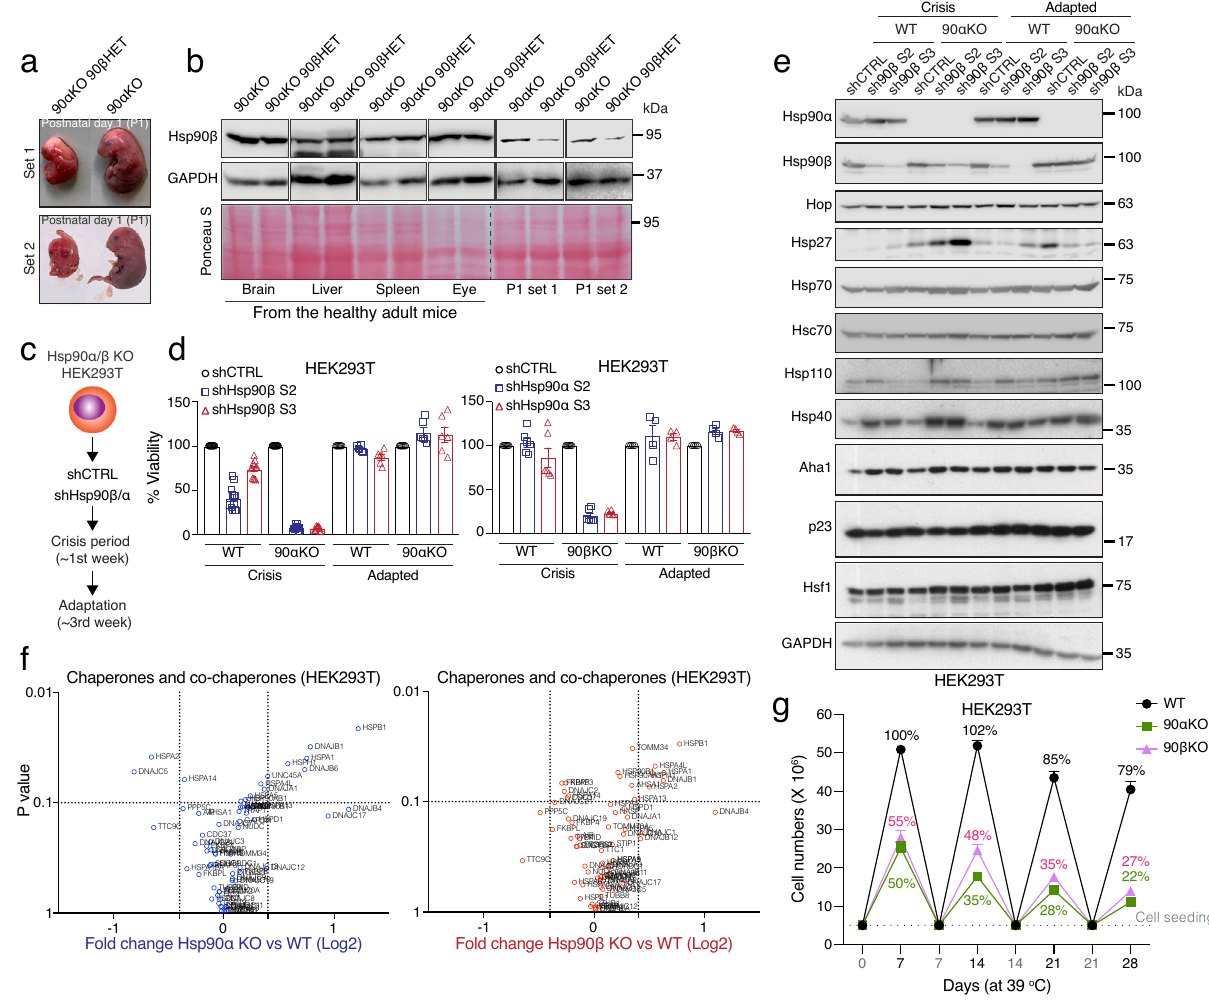
Fig. 4 | Below threshold levels of Hsp90 are detrimental for mammalian life. a Representative image of newborn pups of the indicated genotypes at postnatal day 1. 90 α KO 90 β HET pups are stillborn and developmentally retarded (see also Fig. 1a, c). b Immunoblots of Hsp90 β from the indicated adult tissues